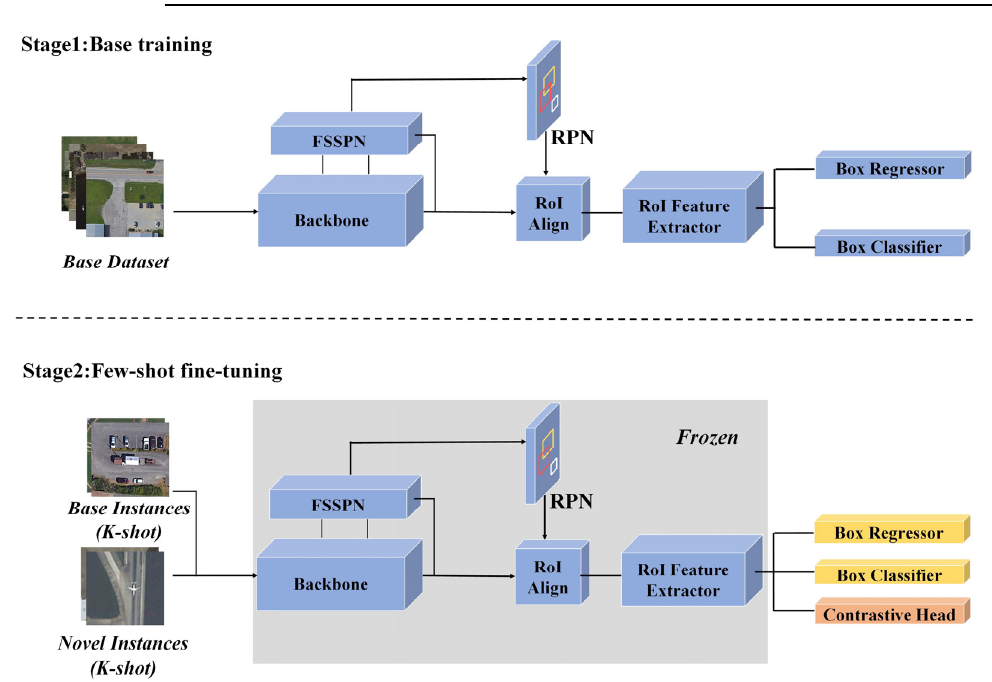
Figure 2. Framework of the proposed method. Algorithm 1. Processing Flow